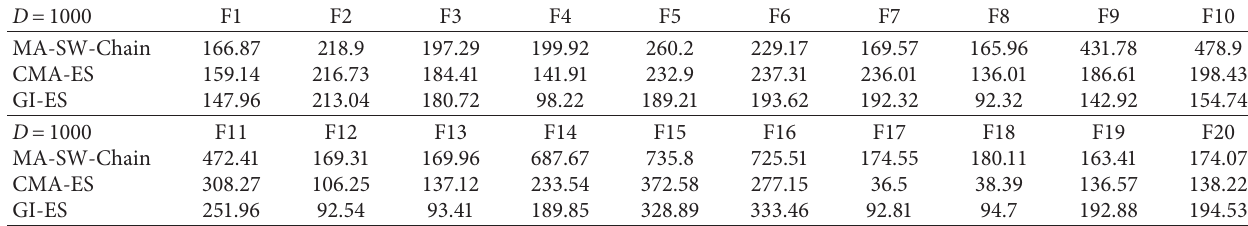
Table 12: CPU computational time of improved CMA-ES and non-improved CMA-ES. D �